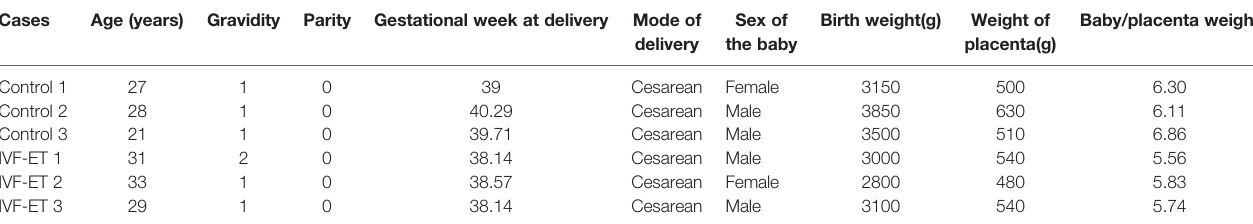
TABLE 1 | Clinical characteristics of IVF-ET and controls for high-throughput